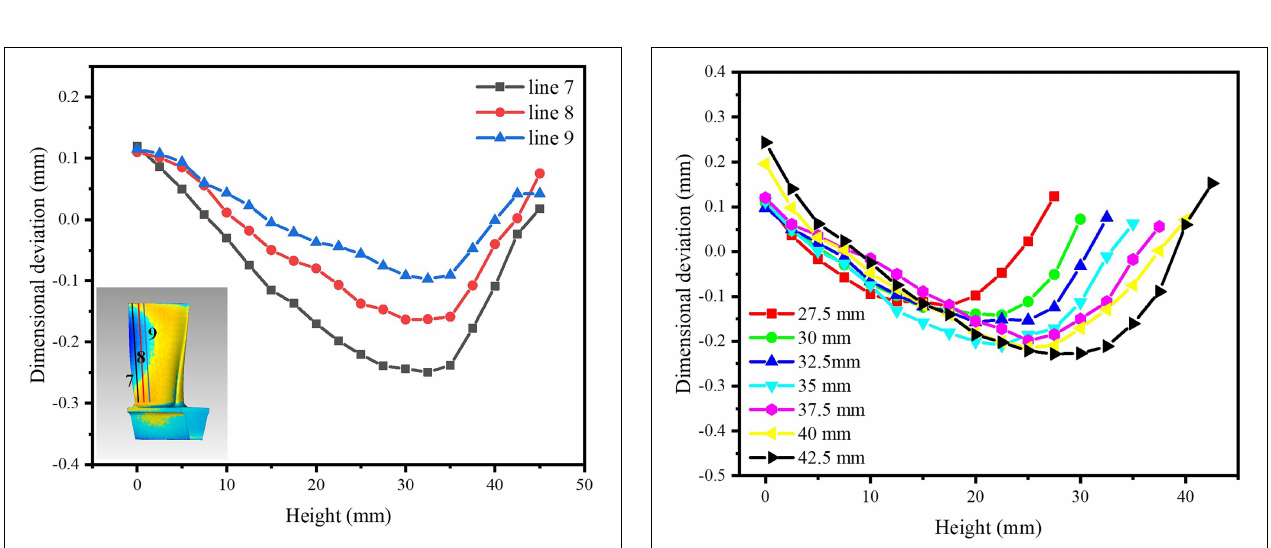
FIGURE 8 | Line charts of the dimensional deviation – the height size of blade, (A) on the pressure surface, (B) on the suction surface.